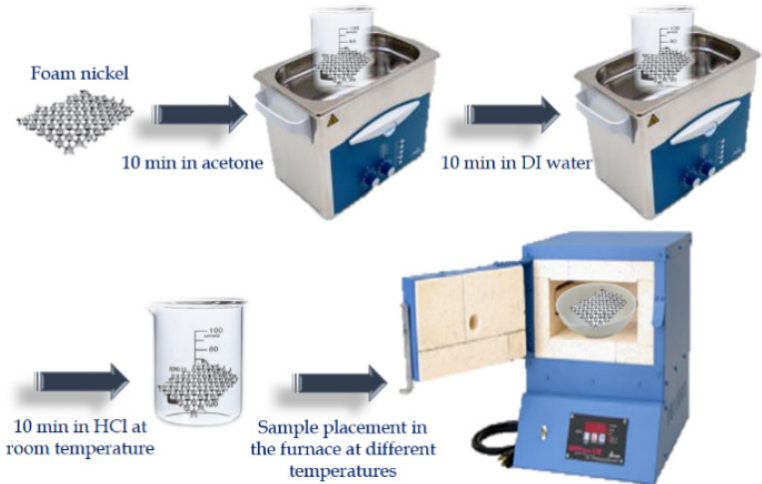
Fig. 1. Schematic illustration of the fabrication process of the NiO nanostructures on the nickel